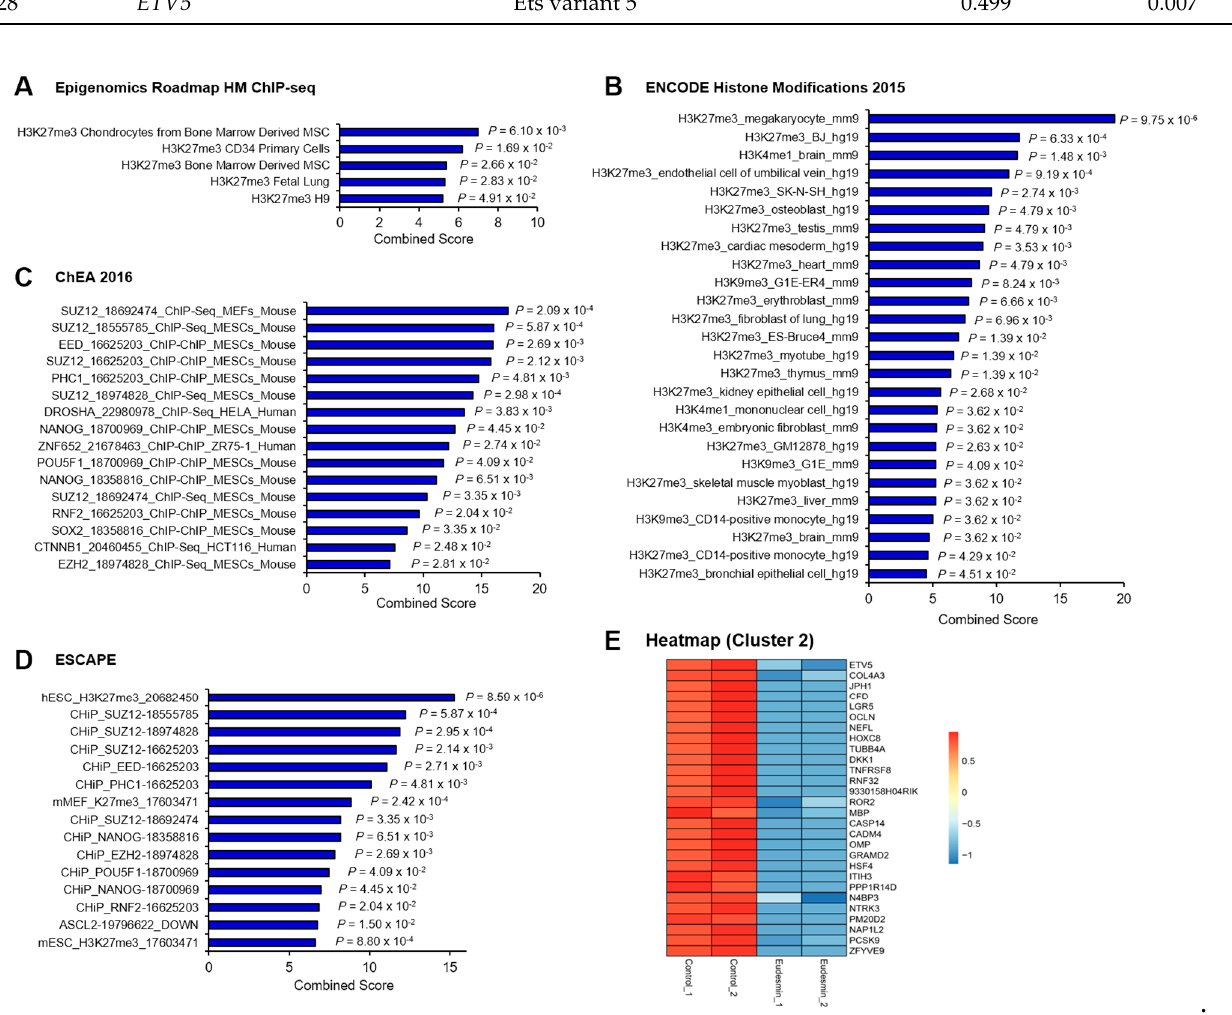
Figure 3. Enrichment of PRC2 target genes in differentially expressed genes by eudesmin treatment. ( A ) Analysis of downregulated genes by eudesmin treatment with Epigenomics Roadmap HM ChIP-seq database in Enrichr. ( B ) Analysis of downregulated genes by eudesmin treatment with ENCODE Histone Modifications 2015 database in Enrichr. ( C ) Analysis of downregulated genes by eudesmin treatment with ChEA 2016 database in Enrichr. ( D ) Analysis of downregulated genes by eudesmin treatment with ESCAPE database in Enrichr. ( E ) Heatmap of PRC2 target genes downregulated by eudesmin (Cluster